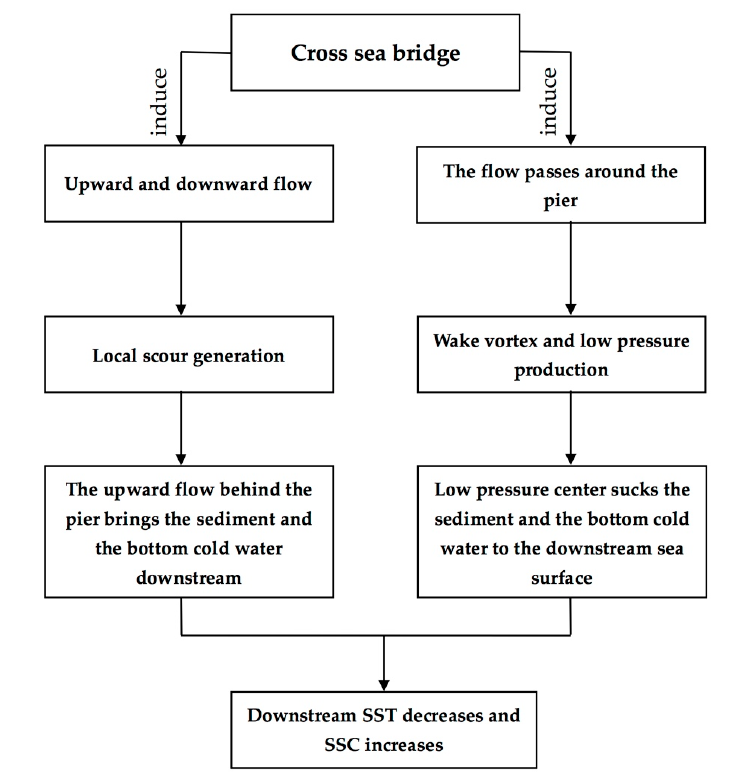
Figure 10. Graphical abstract illustrating how the cross-sea bridge reduces the downstream SST and raises the downstream SSC.